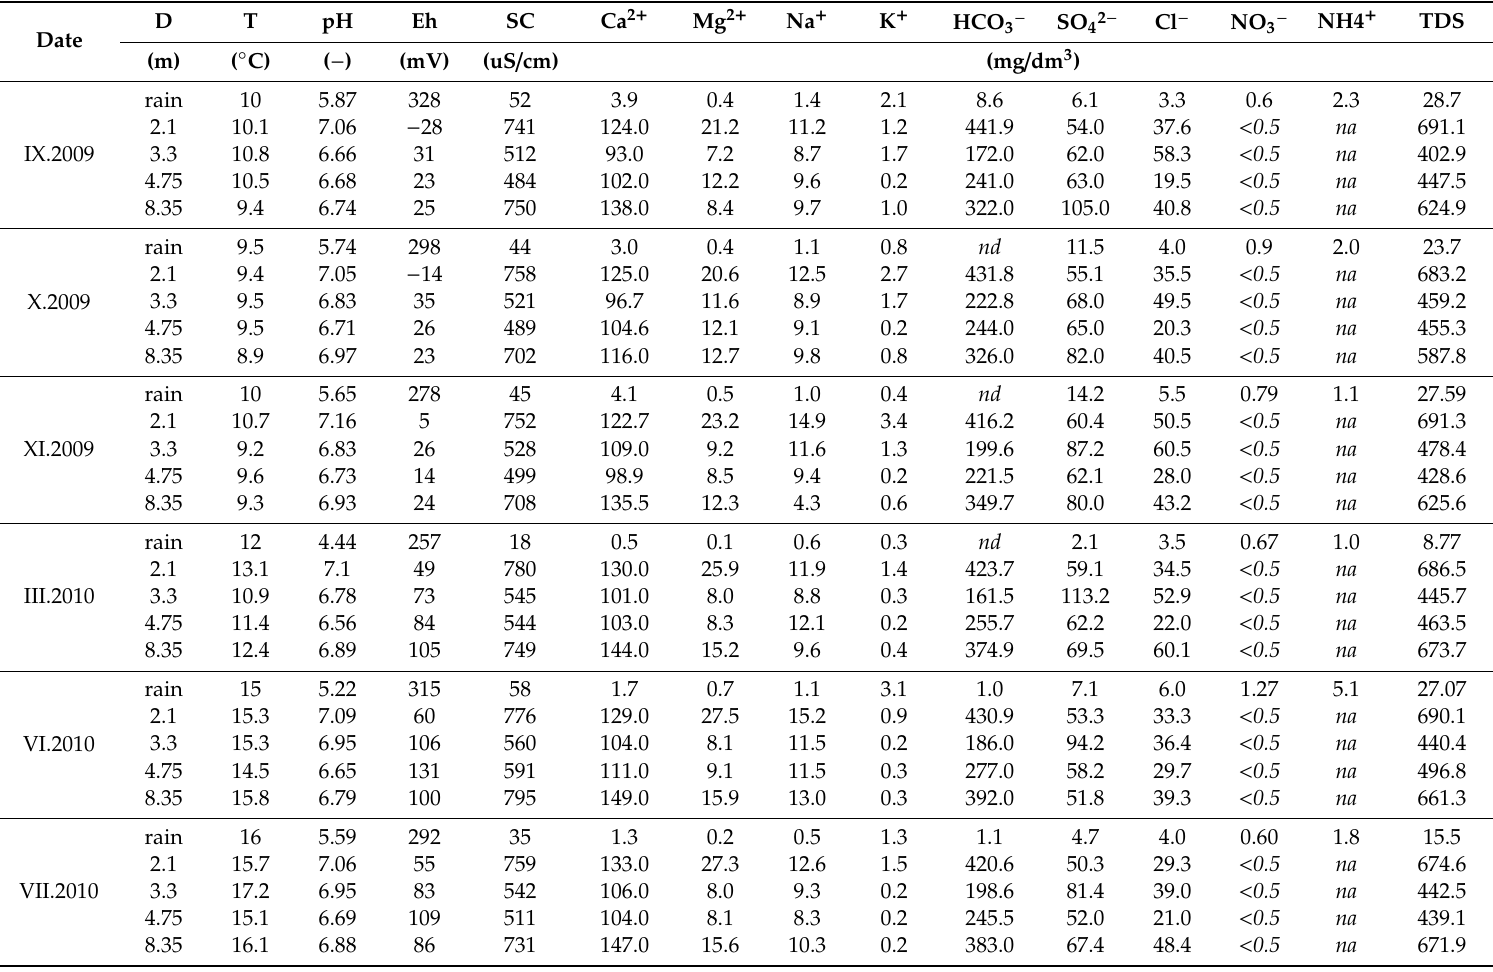
Table 1. Chemical composition of atmospheric precipitation and groundwater from piezometers in the Po˙zary research station. Rainwater is presented for depth 0.0 m. nd —not detected; na —not analyzed; < 0.5 —below detection